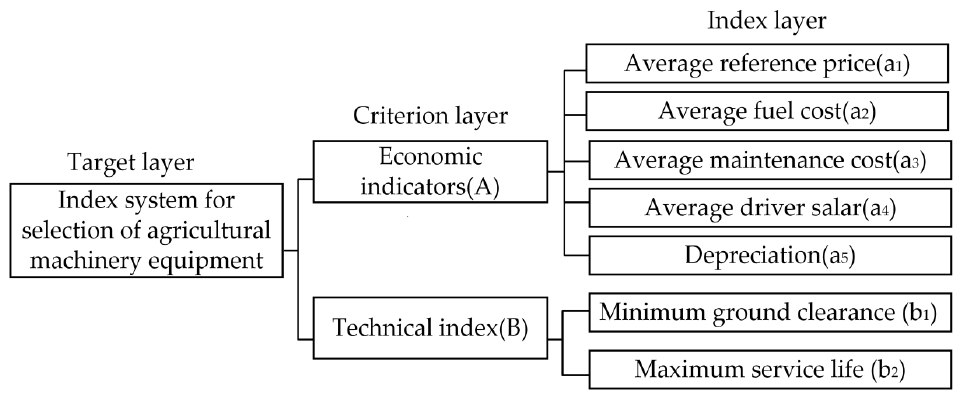
Figure 1. Index system of agricultural machinery selection.